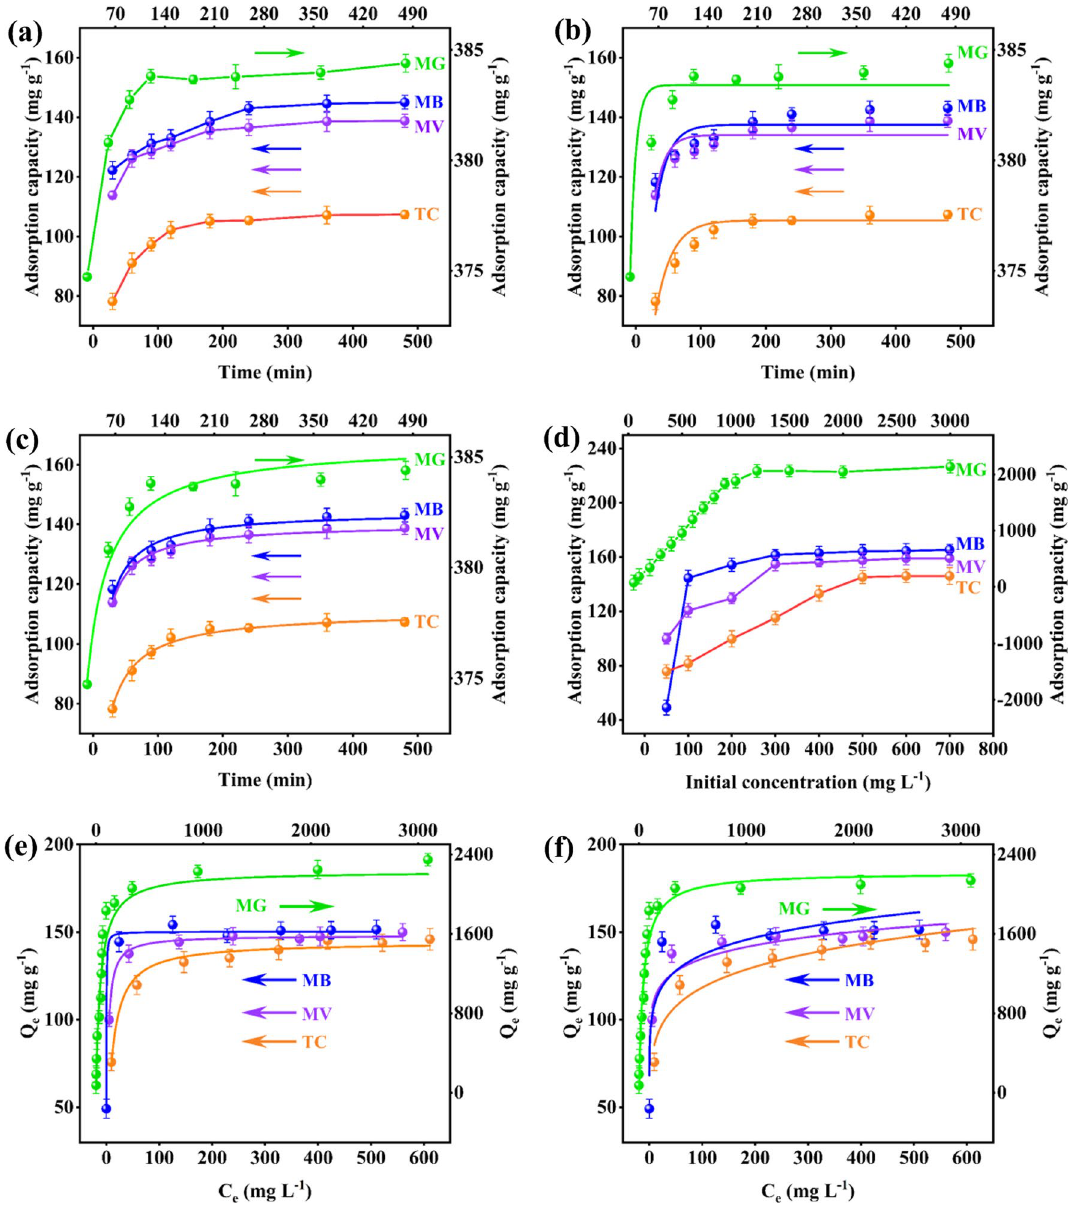
Fig. 6 a Effect of contact time on the adsorption properties of OSSC-2-700 toward four organic contaminants, b pseudo-first-order model and c pseudo-second-order model for fitting the adsorption data. d Effect of initial concentration of four organic contaminants on the adsorption properties of OSSC-2-700, e Langmuir model and ( f ) Freundlich model for fitting the adsorption